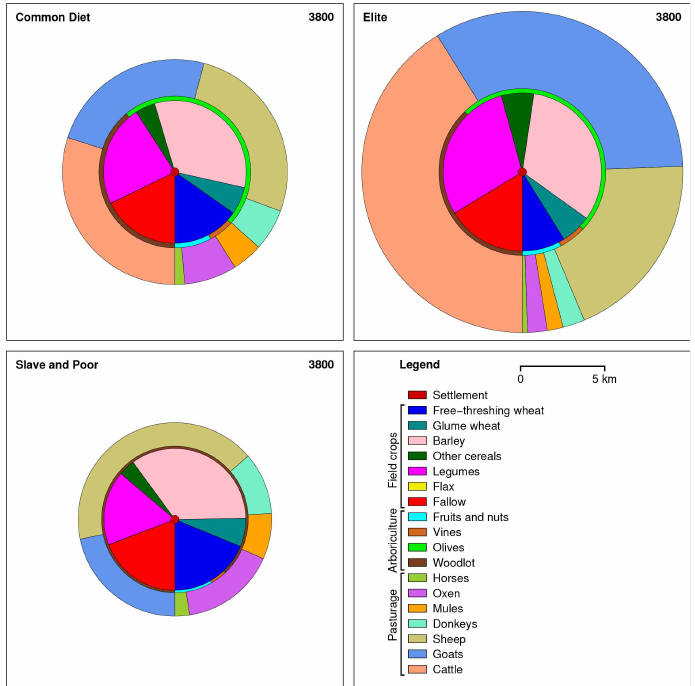
Figure 3. Changing dietary assumptions based on social status (Table 1). The raw numerical results and win-loss diagram are presented in Table